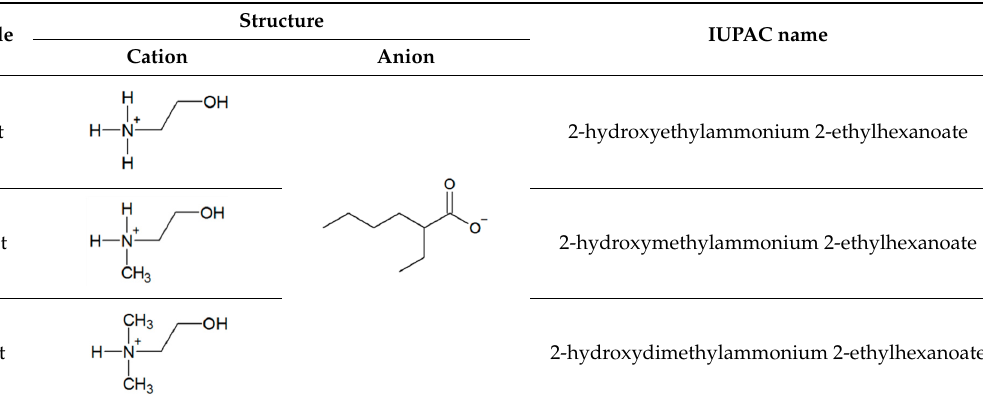
Table 2. The molecular structure, name, and abbreviation of protic ionic liquids (PILs).